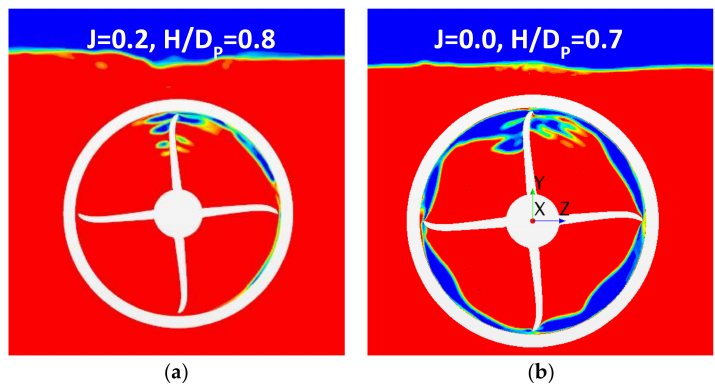
Figure 28. Contours of volume fraction under fully ventilated conditions at low speed operation conditions: ( a ) J = 0.2, H/Dp = 0.8; ( b ) J = 0.0, H/Dp = 0.7. Table 7. Computed single blade loads at J = 0.2 for different magnitudes of propulsor submergence.